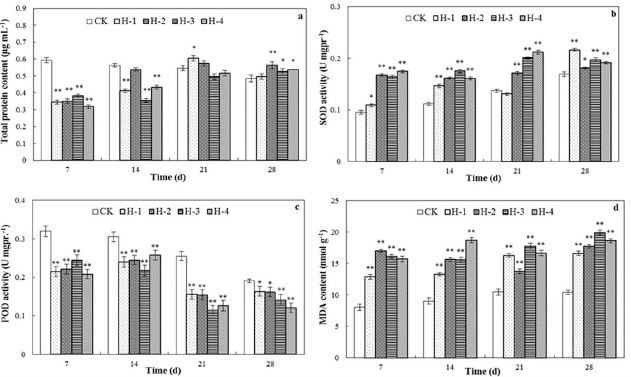
Fig 1. Toxicity effects of DEHP on biochemical properties of E . fetida in the spiked soil test. (a) total protein content; (b) SOD activity; (c) POD activity; and (d) MDA content were determined after treatment for 7, 14, 21 and 28 d in spiked natural soil CK, H-1, H-2, H-3, and H-4 (n = 4; error bars, SEM/mean value of standarderrors). The spiked concentrations of DEHP were 0, 1, 3, 9 and 27 mg kg -1 soil. Asterisks show significantdifferences at p < 0.05level compared to the control; doubleasterisks show significantdifferencesat p < 0.01level comparedto the control (S1 Data).